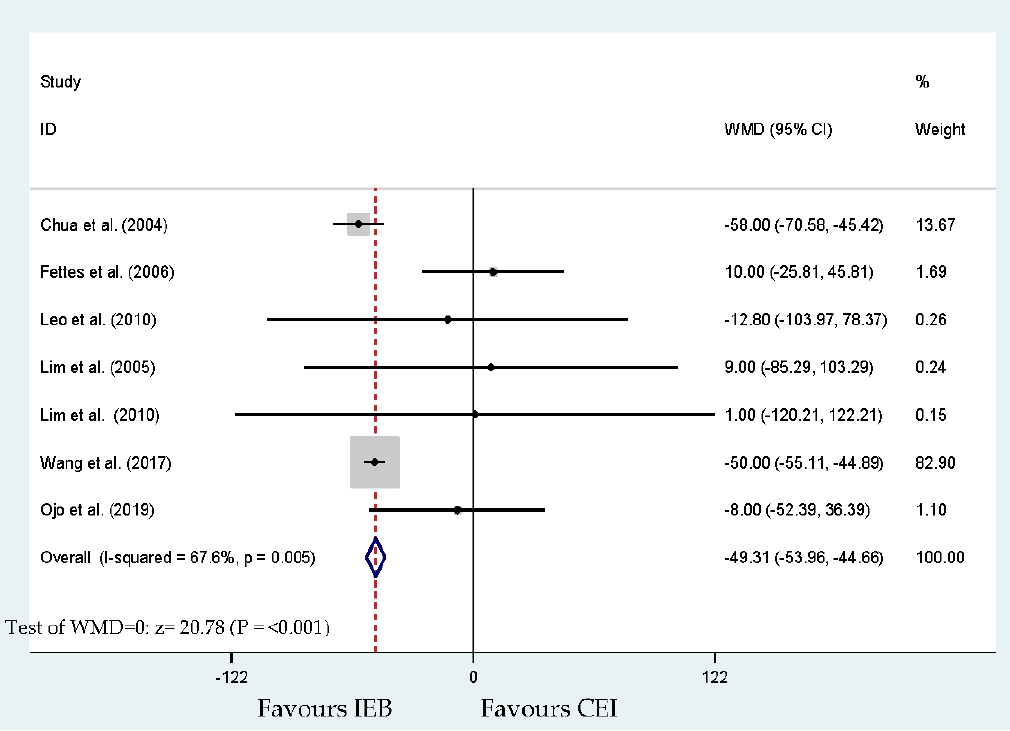
Figure 6. Overall e ff ect for time (minutes) to first requirement of anesthetic Figure 6. Overall effect for time (minutes) to first requirement of anesthetic intervention.